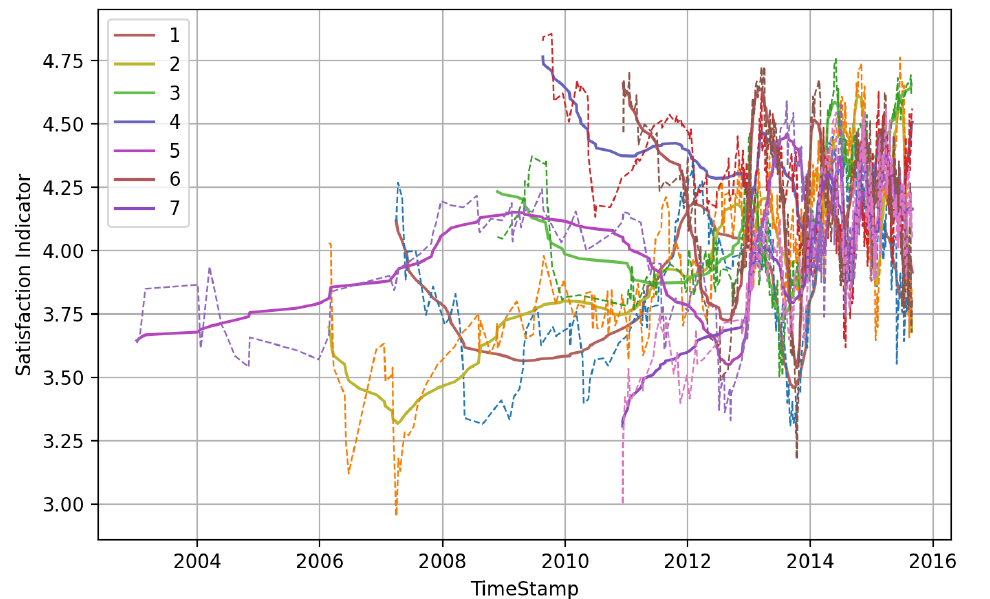
Figure A3. Satisfaction curve of different brands of hair dryer. The seven lines in the picture represent these commodities: 1 refers to the Andis 1600 Watt quiet hangup hair dryer with night light; 2 refers to the Andis 1875 Watt Fold-N-Go ionic hair dryer, silver/black (80020); 3 refers to the Conair 1875 Watt cord keeper 2-in-1 hair dryer, black; 4 refers to the Conair 1875 Watt tourmaline ceramic hair dryer; 5 refers to the Conair Corp Pers Care 146NP ionic conditioning 1875 Watt hair dryer; 6